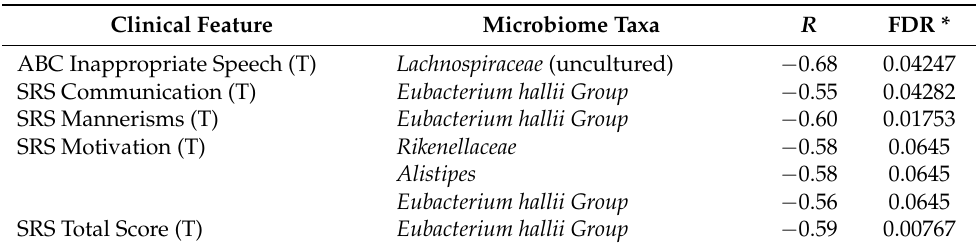
Table 4. Significant correlations between primary outcomes and microbiota relative abundance in probiotic group and placebo group subjects based on Spearman’s rank